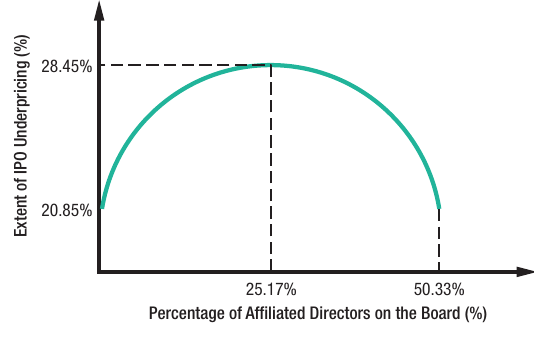
Percentage ofAffiliated Directors on the Board Fig. 1. Extent of IPO underpricing